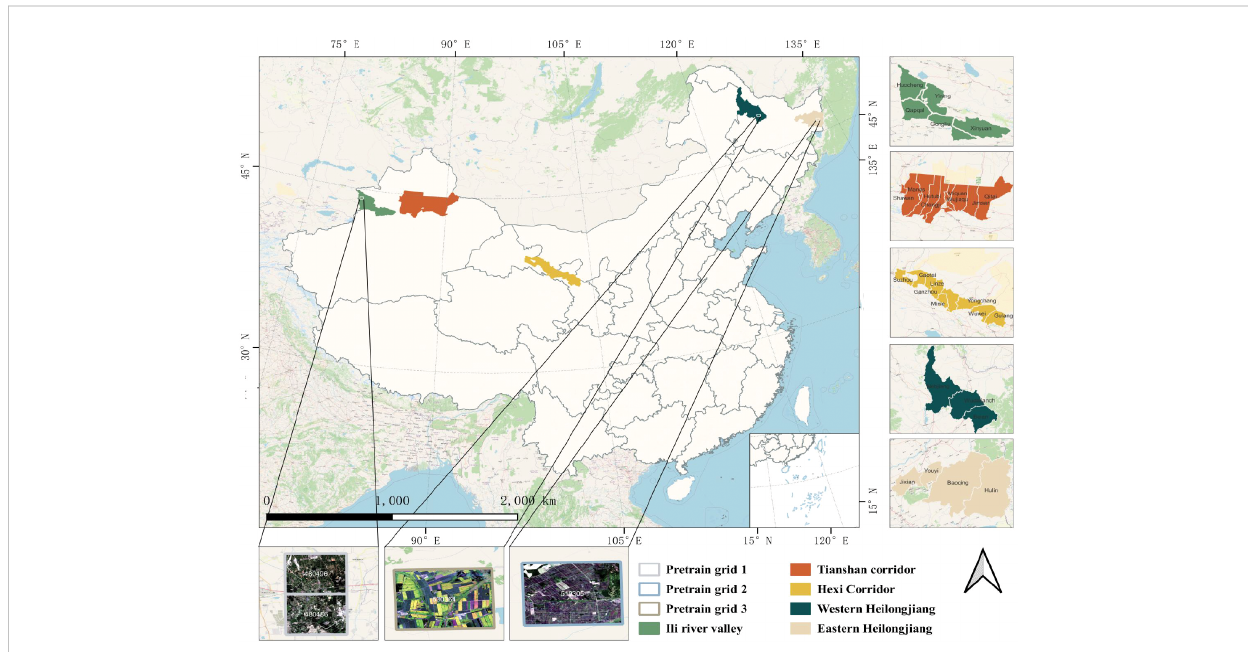
FIGURE 1 The geographical locations of the fi ve study areas in China. The data used for pre-training are from the white boxed area in the Ili River Valley, Western Heilongjiang and Eastern Heilongjiang. The lower part shows a remote sensing image of GaoFen